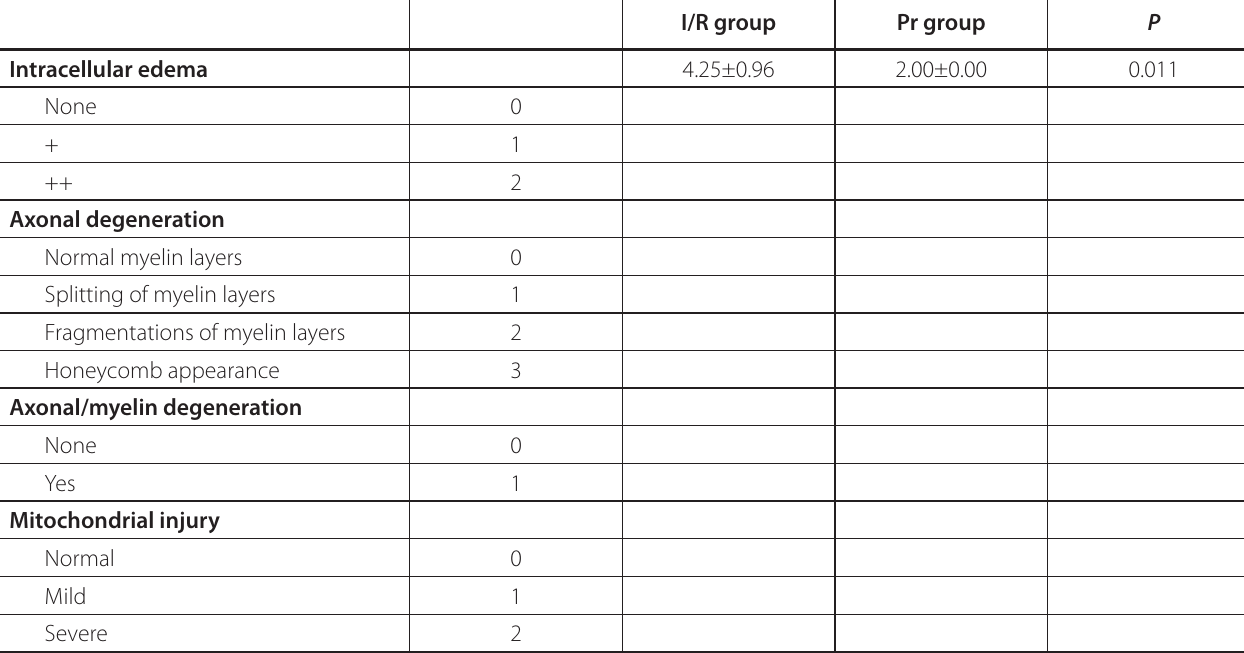
Table 1 . Electron microscopic scoring criteria for